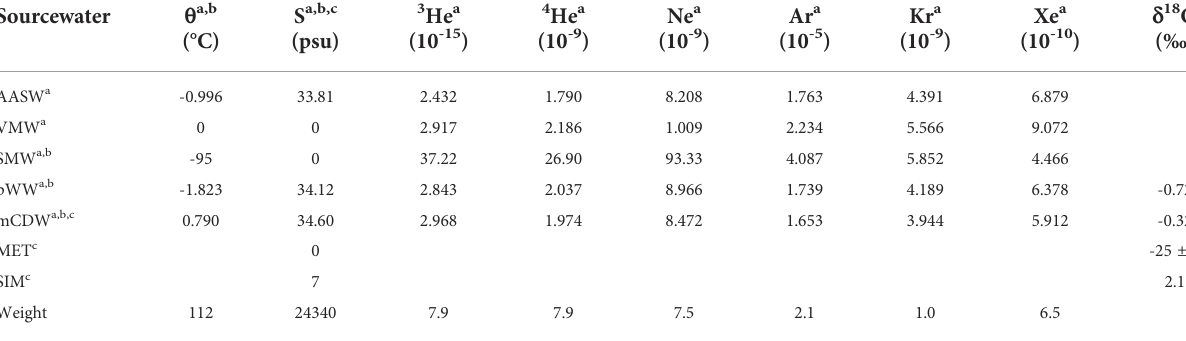
TABLE 1 Properties of the source waters for water mass analysis. Gas concentration units are mol kg -1